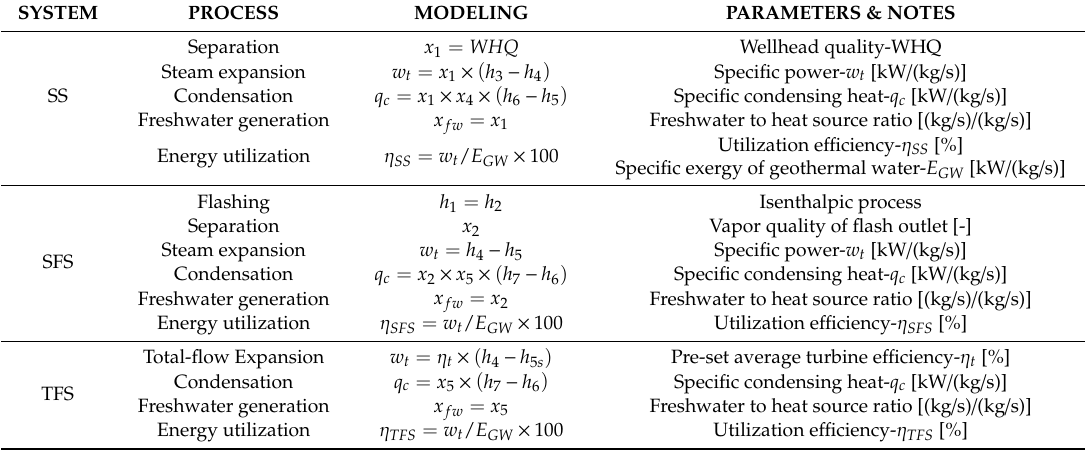
Table 1. Modeling